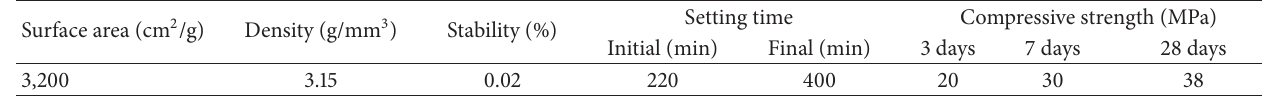
Table 2: Physical properties of cement.